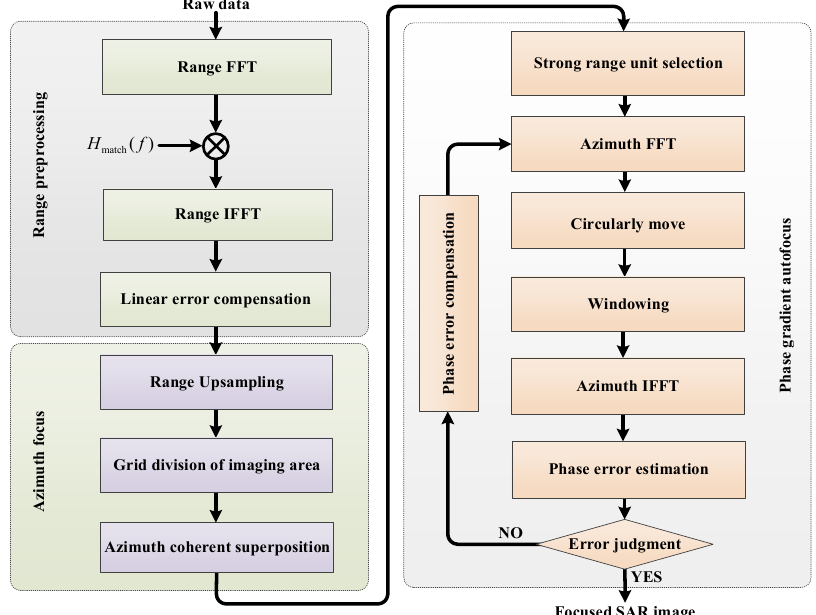
Figure 7. Block diagram of the modified BPA for the proposed imaging mode.